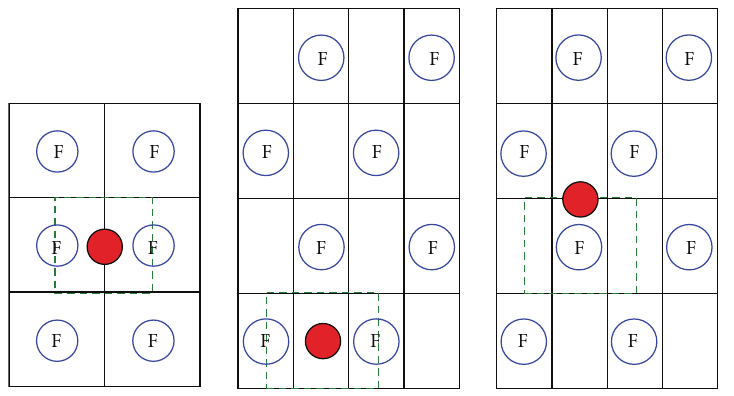
Figure 3: HELIOS control rod models.